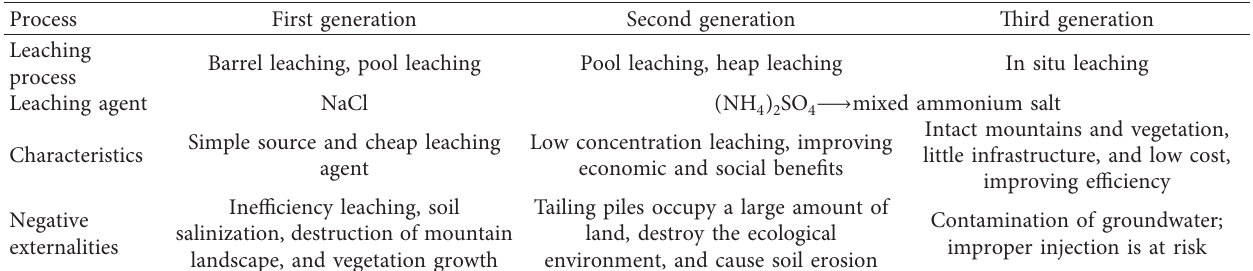
Table 1: Weathered crust elution-deposited rare earth ore process characteristics and negative external effects